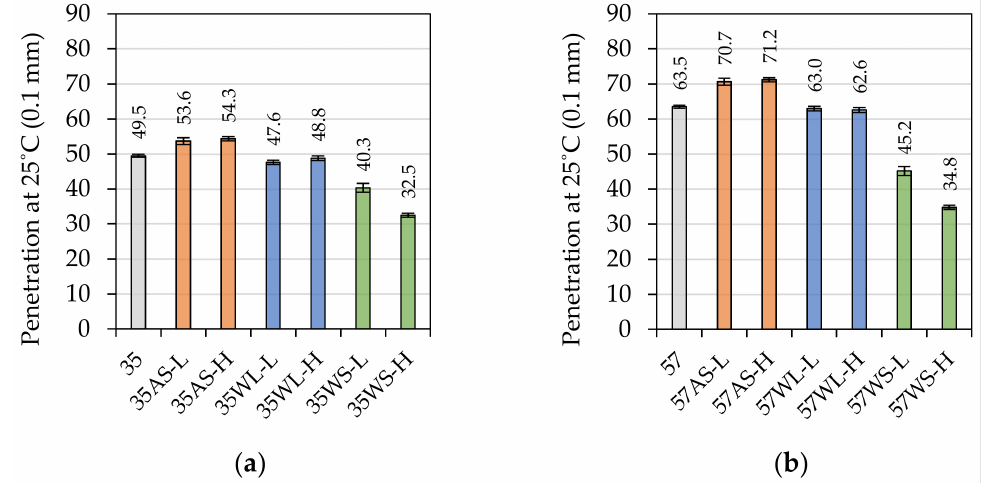
Figure 2. Penetration at 25 ◦ C of the investigated asphalt binders based on the ( a ) 35/50- and ( b ) 50/70-penetration